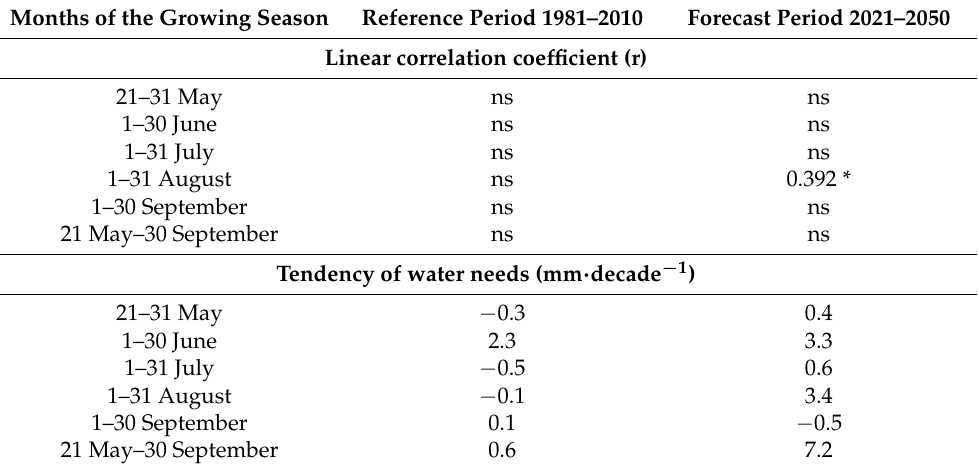
Table 5. The significance of the equations of trends water needs of Jerusalem artichoke and their tendencies in the reference and in forecast